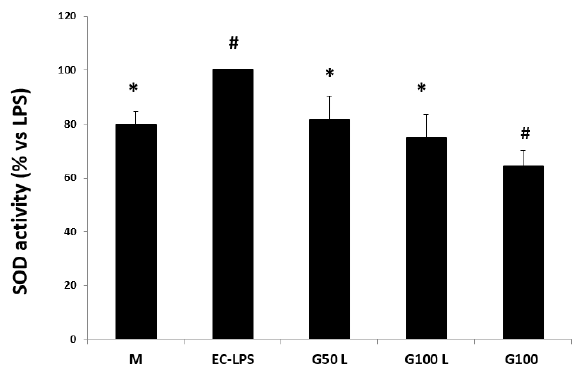
Figure 13. GAAE pre-treatment effect on SOD activity in UC patients challenged with EC-LPS . Biopsies were treated only with medium culture (M), or with 1 mg/mL of EC-LPS or pretreated for 3 h with 50 and 100 µ g/mL GAAE, then challenged for 18 h with EC-LPS (G50 L and G100 L) or treated only with 100 µ g/mL GAAE (G100). Results are expressed as a percentage of each treatment with respect to EC-LPS ± S.E.M. ( N = 31), * p < 0.05 vs. EC-LPS, # p < 0.05 vs. medium (Student’s t test).